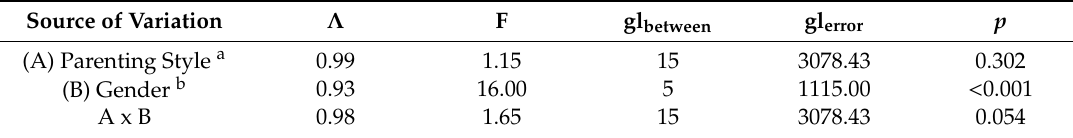
Table 5. MANOVA factorial (4 a × 2 b ) for adolescent dating violence (online and o ffl ine) for fathers ( N = 1132).